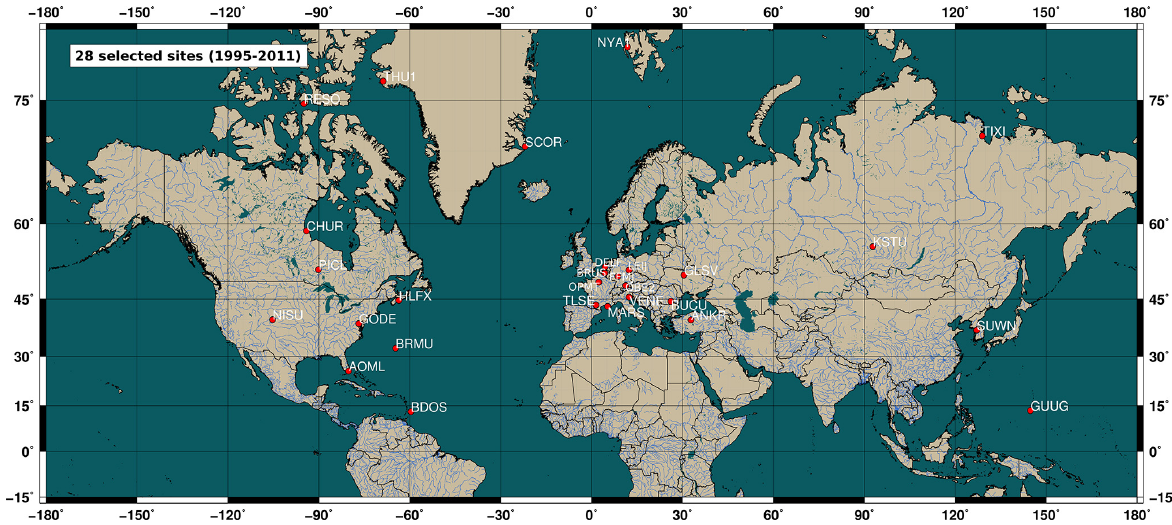
Figure 2. Map of the selected sites that host at least 2 of the considered ground-based or in situ instruments, next to the satellite overpass